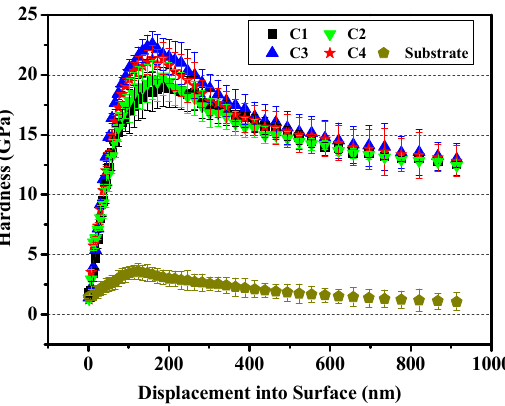
Figure 3. Nano indentation curves of 316L substrate and all films.